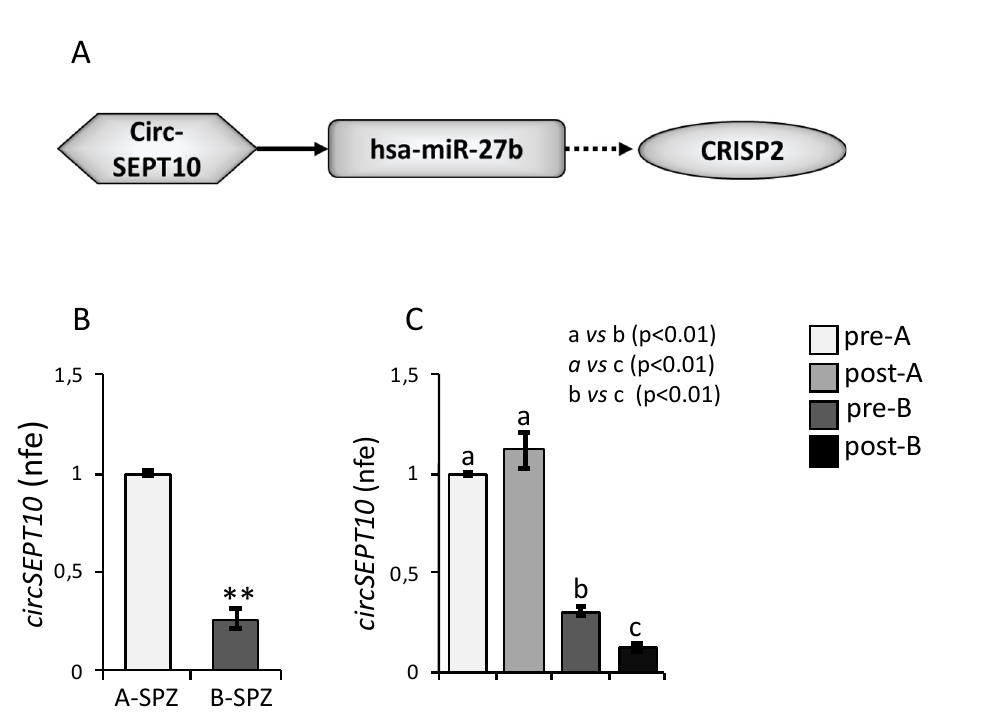
Figure 4. Expression of circSEPT10 in Asthenozoospermic Patients. ( A ) Functional clustering of one circRNA upregulated in asthenozoospermic A-spermatozoa. CircSEPT10 tethers a miRNA involved in CRISP2 mRNA regulation. Networks were built using Cytoscape. Hexagonal and rectangular symbols represent circRNAs and miRNAs, respectively, while the elliptic symbol represents the mRNA target. The arrow indicates the tethering activity of circSEPT10 toward miRNA, while the dotted arrow indicates the inhibiting activity of miRNAs toward CRISP2 . ( B ) Differential expression analysis of circSEPT10 between A-spermatozoa and B-spermatozoa collected from asthenozoospermic patients by qRT-PCR. ( C ) Expression of circSEPT10 in A-spermatozoa and B-spermatozoa collected from asthenozoospermic patients before (pre-A; pre-B) and after (post-A; post-B) an oral amino acid supplementation therapy. All qRT-PCR data were normalized by using GAPDH , expressed as normalized fold expression (n.f.e.) and reported as mean value ± S.E.M. Experimental groups with statistically significant differences ( p < 0.01) were indicated with different letters; the experimental groups without statistically significant differences were indicated with the same letter. **: p < 0.01.